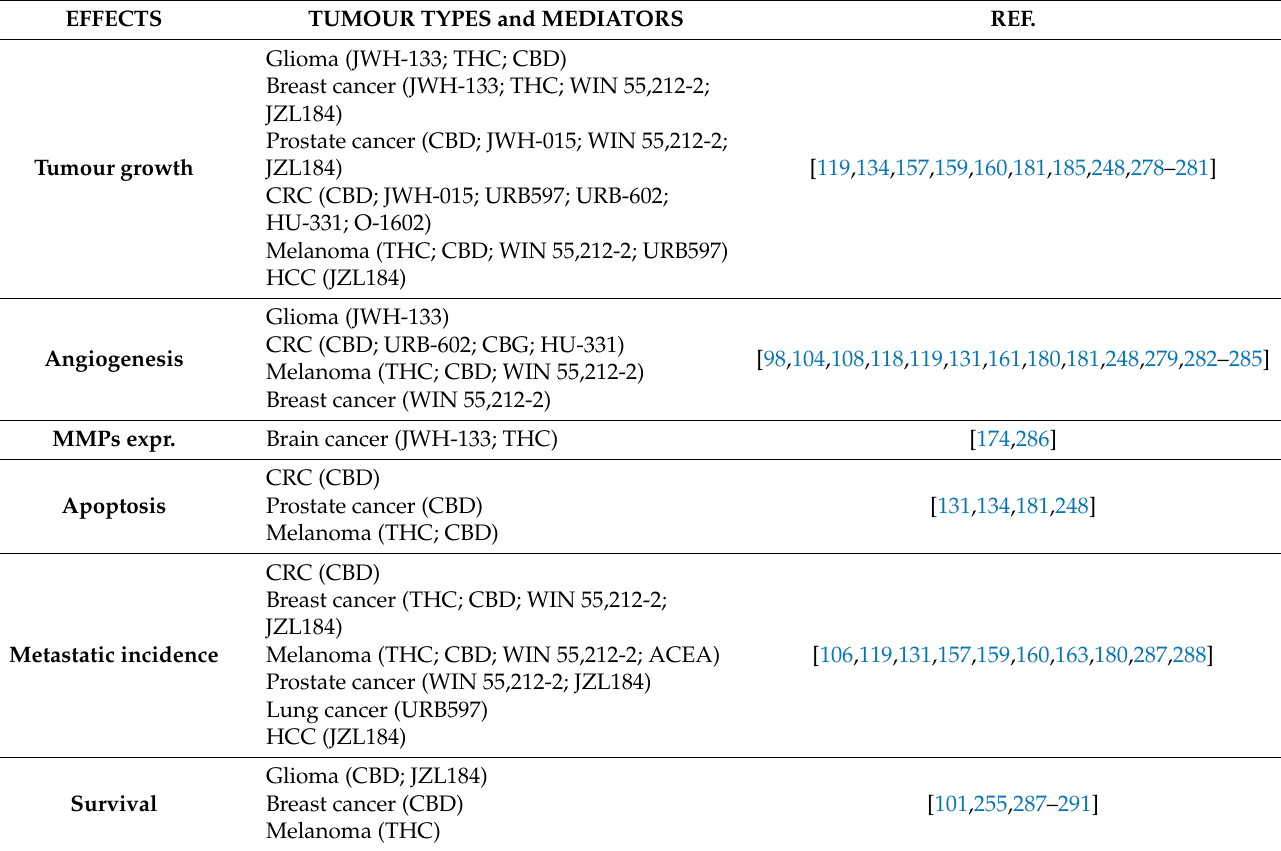
Table 4. Anticancer cannabinoid effects in murine preclinical